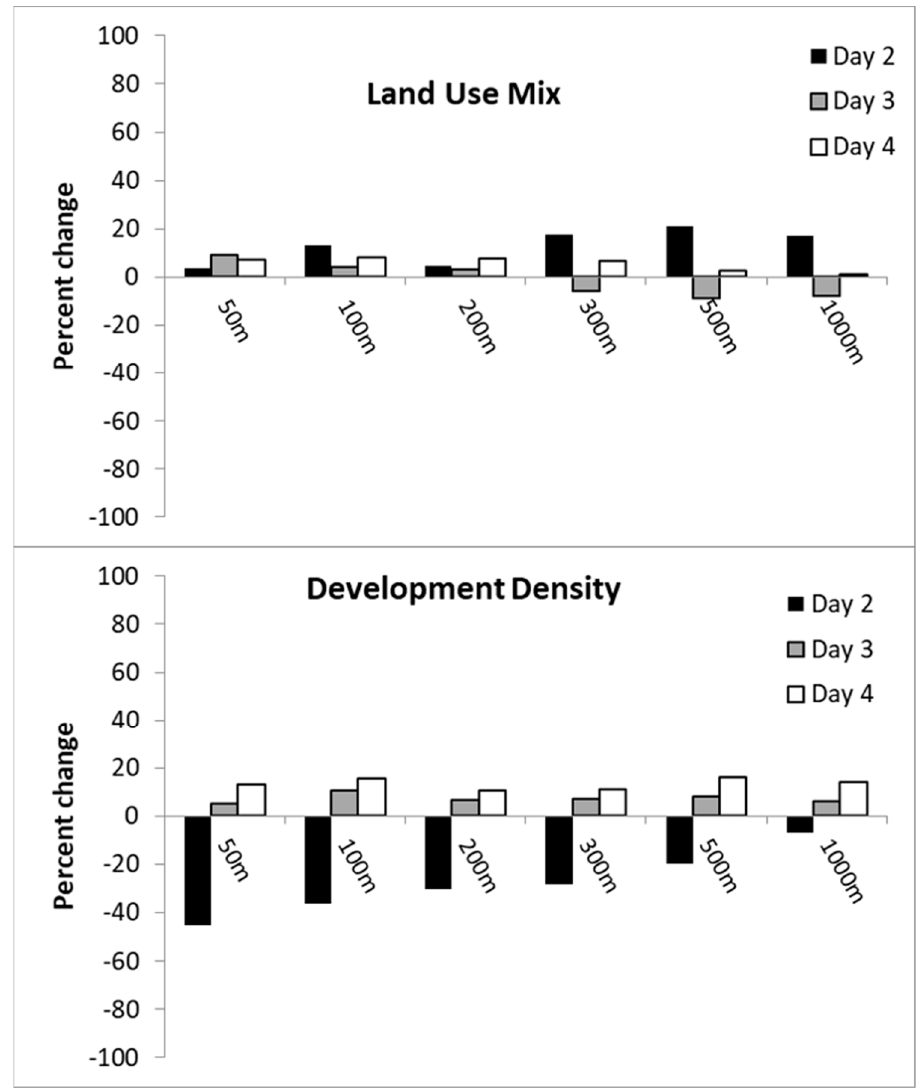
Figure 12. Percent change in land use mix and development density predictor variables between the 20% most heavily polluted segments of the cycled network and the remainder of the cycled path.